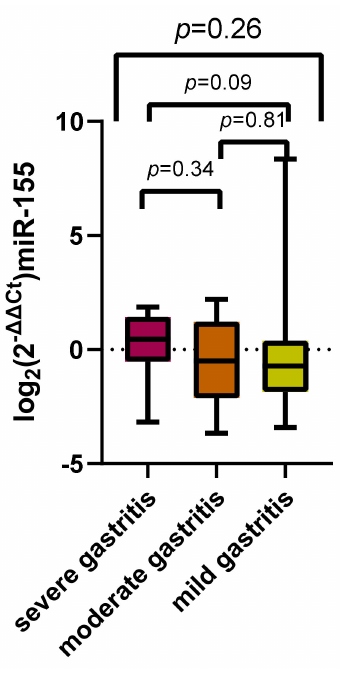
Figure 7. Log 2 (2 − ∆ Ct ) miR-155 comparison between patients with severe, moderate, and mild